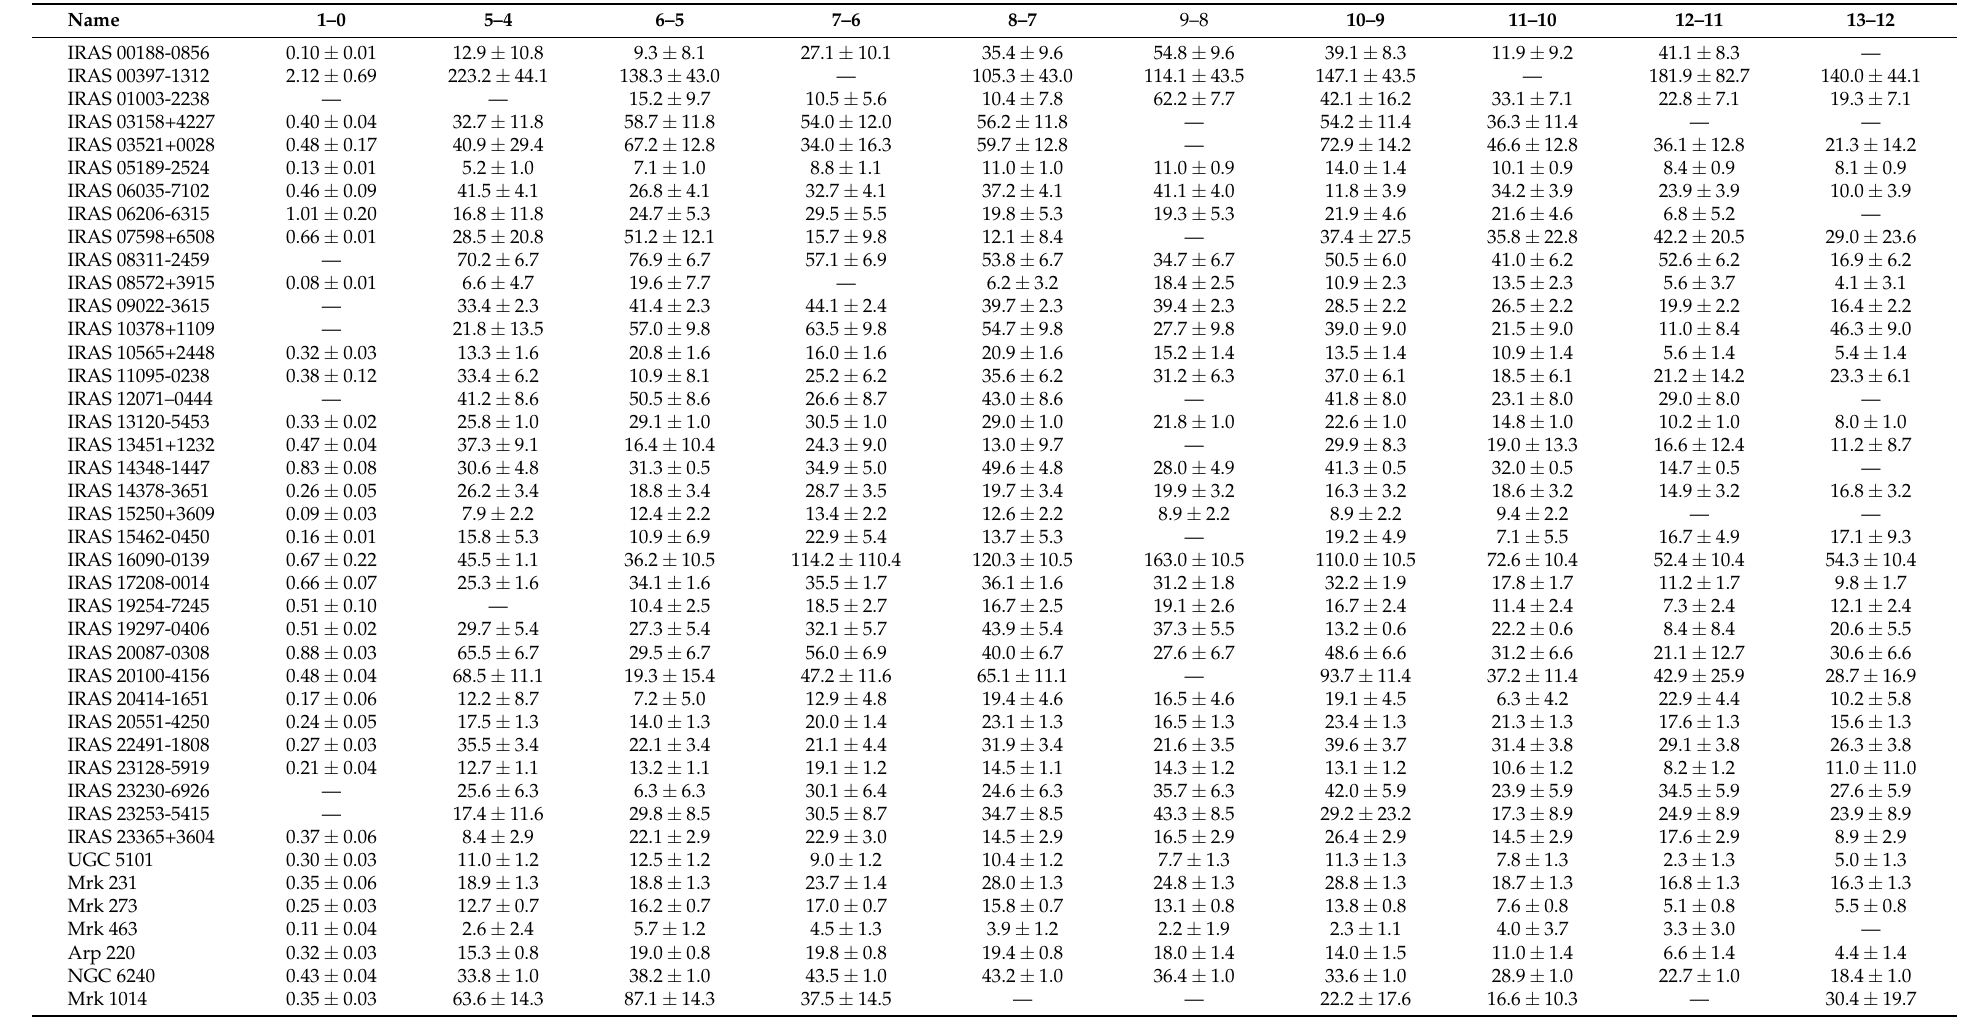
Table 1. The sample and their CO luminosities. All luminosities are derived from measurements using single-aperture telescopes (Section 2.2). Units are 10 6 L Uncertainties are 1 σ